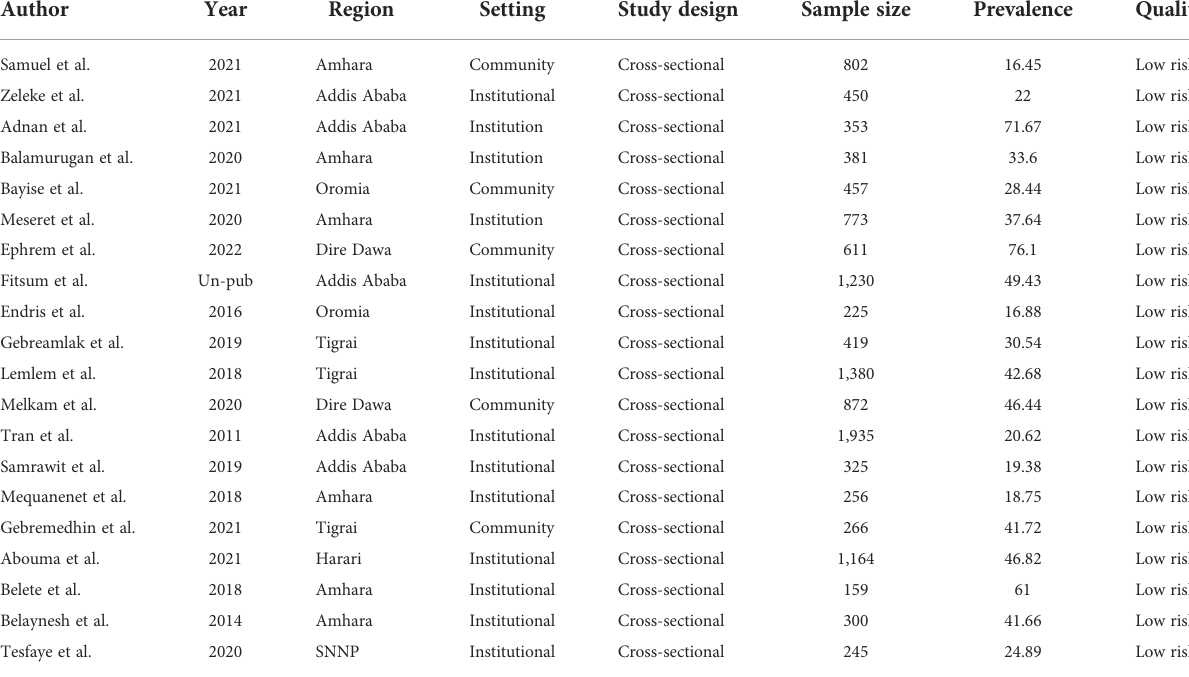
TABLE 1 Summary characteristics of studies included in the meta-analysis.